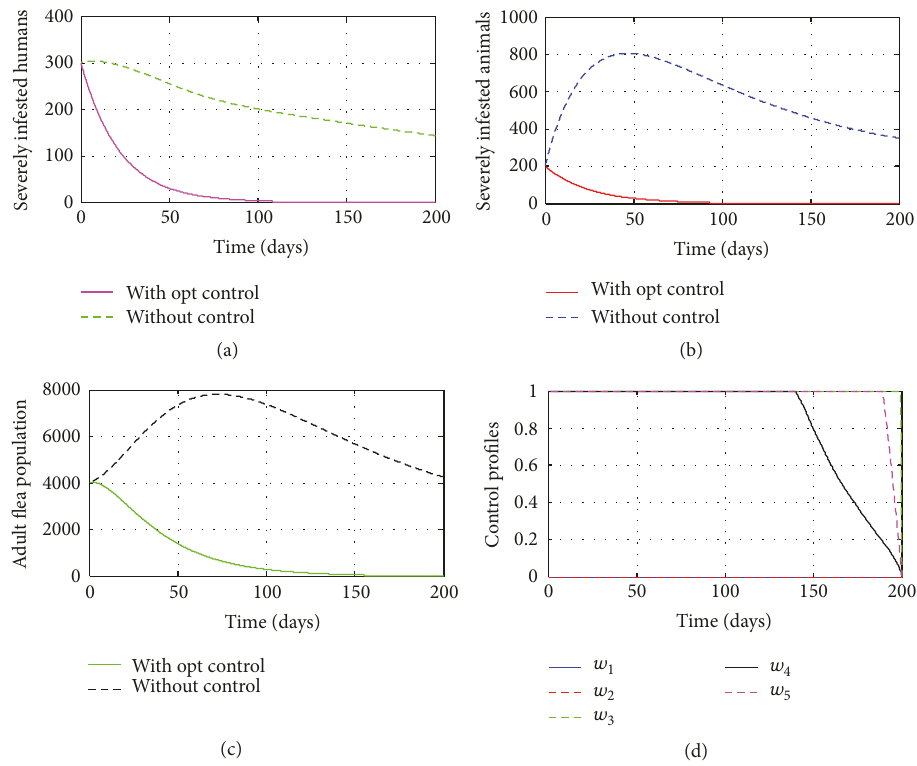
Figure 5: Optimal solutions for model variables 𝐼 𝐻ℎ , 𝐼 𝐴ℎ , 𝐹 𝐸 and the control profiles for 𝑤 1 , 𝑤 2 , 𝑤 3 , 𝑤 4 , 𝑤 5 with (𝑤 3 , 𝑤 4 ,𝑤 5 ̸= 0) .